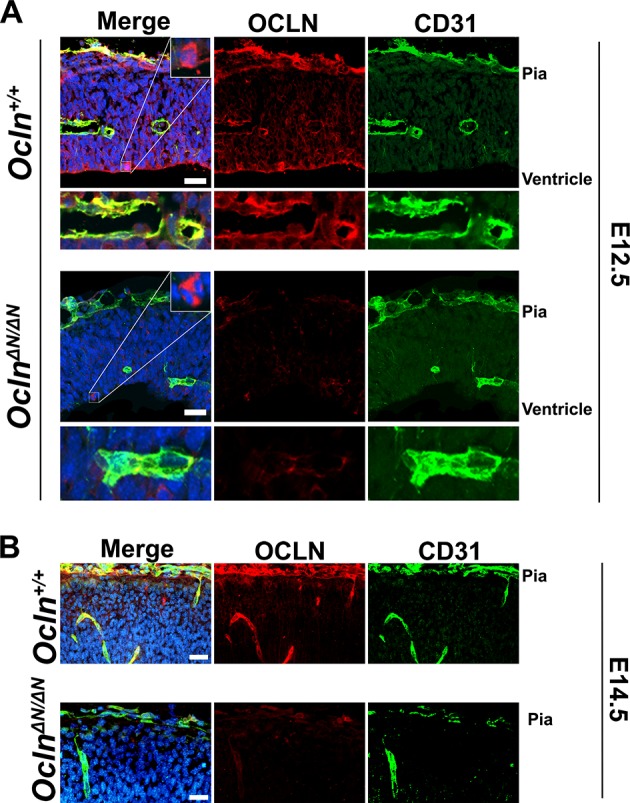
mOCLN-FL co-localizes with vascular endothelial marker, CD31, in Ocln+/+ but not Ocln∆N/∆N embryonic cortex.(A) Confocal images of mouse coronal sections at E12.5 stained with OCLN C-term antibody (red) and vascular endothelial cell marker CD-31 (green). The OCLN antibody detects both full-length and truncated OCLN isoforms. Insets show OCLN labeling of the mitotic spindle apparatus of dividing progenitors at the ventricular surface in both WT and ∆N/∆N genotypes. Scale bar 30 μm (B) Confocal images of mouse coronal sections at E14.5 stained with C-term OCLN and CD-31 antibodies. Full-length OCLN continues to be robustly expressed in vascular endothelial cells despite developmental down regulation of the full length OCLN protein in neural cells of Ocln+/+ cortex. However, mOCLN-FL is absent in vessels in the mutant brain. Scale bar, 30 μm.